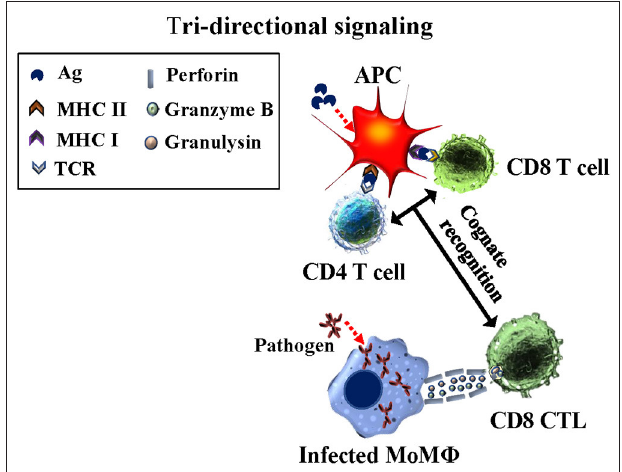
FIGURE 5 | Diagram illustrating the concurrent tri-directional signaling required for development of CD8 CTL during the primary immune response and eliciting a CD8 CTL recall response. Antigen must be taken up and processed by APC for presentation in context of MHC I and MHC II molecules. CD4 and CD8T cells must recognize their respective epitopes concurrently interfaced with the APC. Reciprocal signaling occurs from the APC to CD4 and CD8T cells. Essentiall signaling also occurs between CD4 and CD8T cells while in contact with the APC (